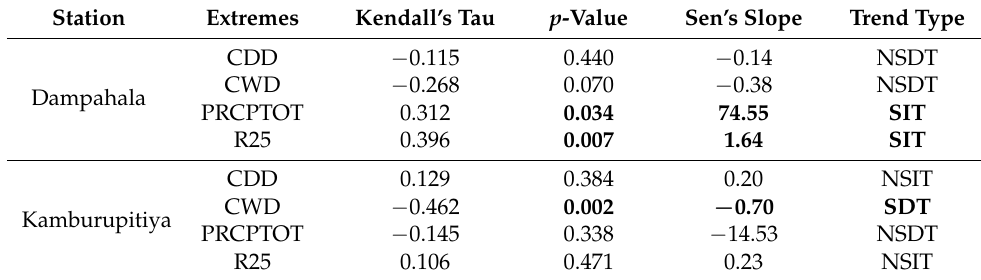
Table 5. Trend analysis results for the extreme rainfall